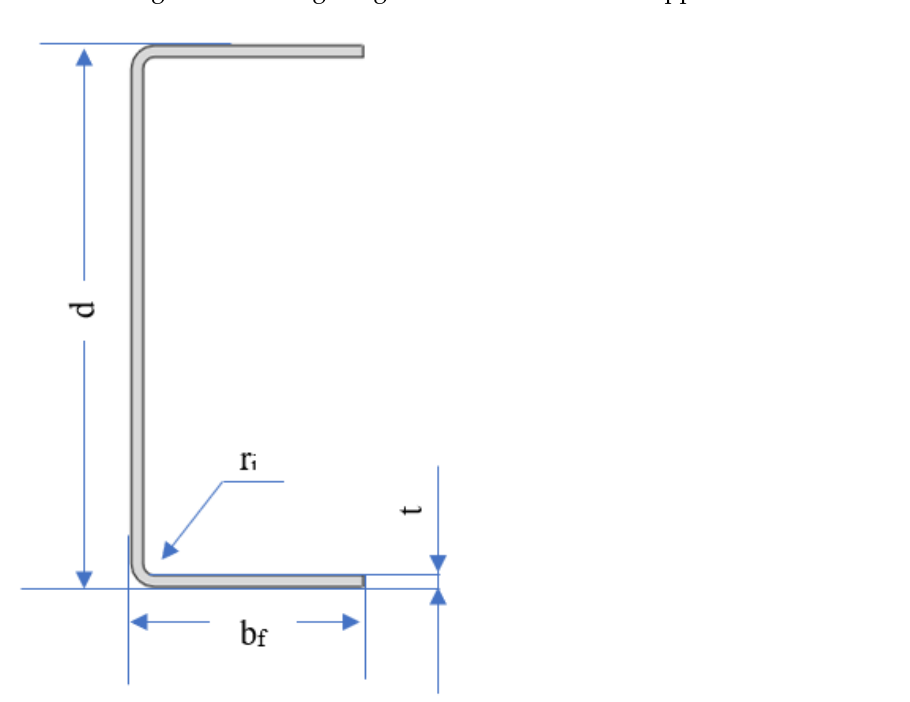
Figure 15. Notations used for key cross-sectional dimensions.